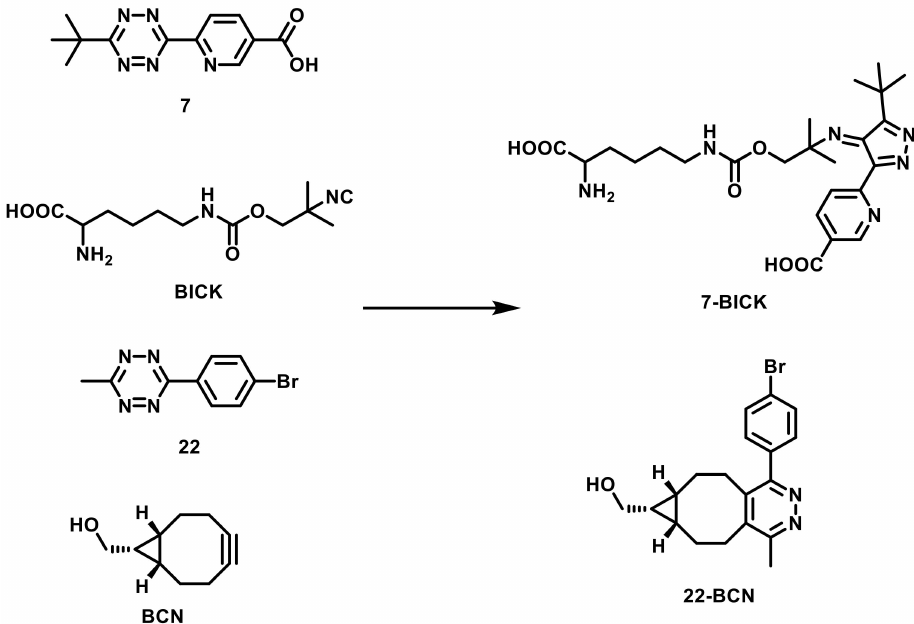
Scheme 4. Reaction products of sterically different tetrazines with bulky isonitrile and cyclooctyne reaction